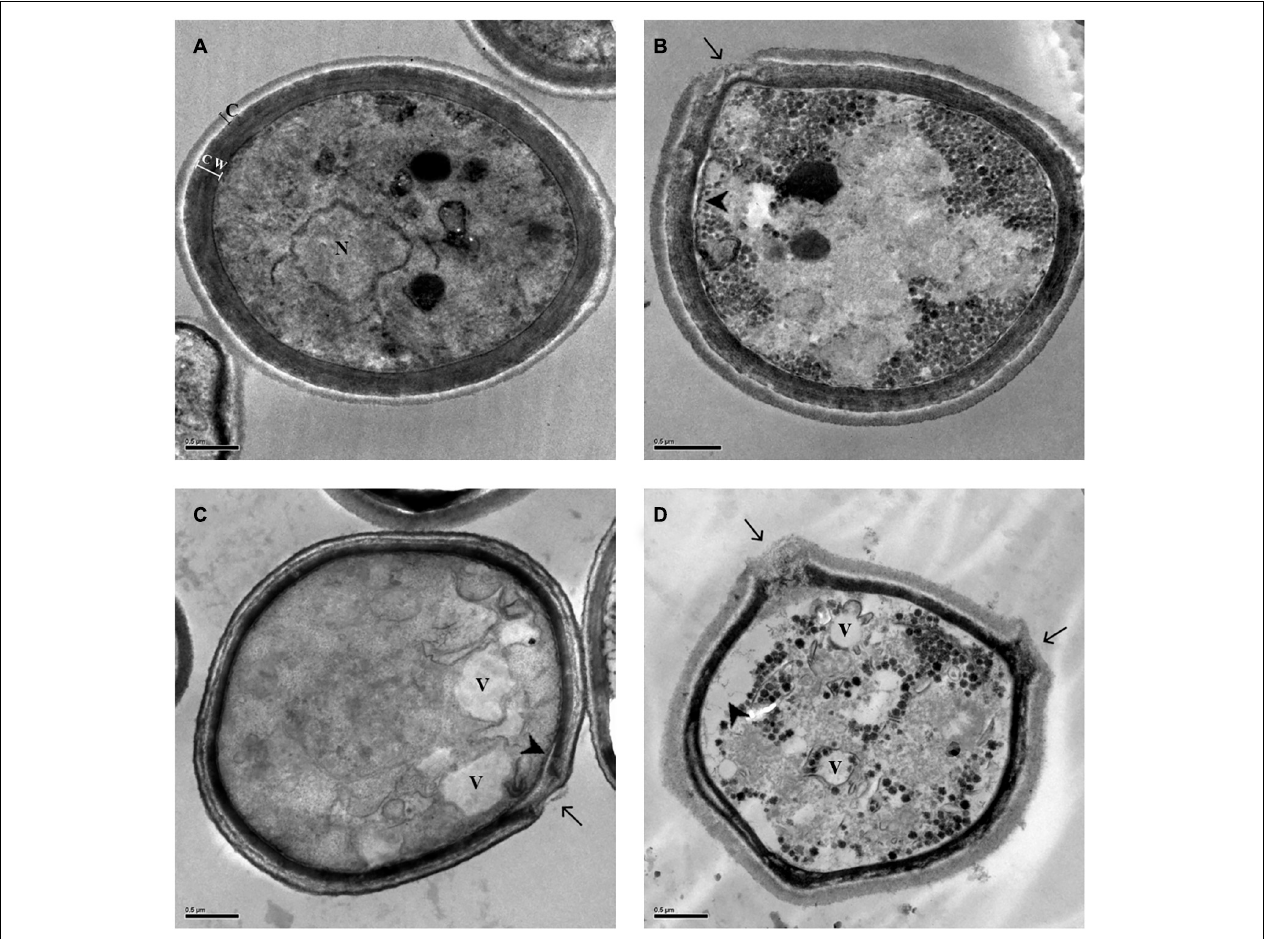
FIGURE 2 | Morphological and ultrastructural changes analyzed by transmission electron microscopy (TEM) in Cryptococcus neoformans ATCC 66031 after 48 h of treatment with ethyl acetate fraction (EAF) and amphotericin B (AmB) alone or combined. (A) Untreated control cells grown in RPMI-MOPS for 48 h at 37 ◦ C; (B) 1,000.0 µ g/ml EAF; (C) 0.125 µ g/ml AmB; (D) 3.9/0.003 µ g/ml EAF/AmB. Capsule (c), cell wall (cw), nucleus (n), vacuole (v), loss of cell wall integrity (arrow), and cell membrane detachment (arrow